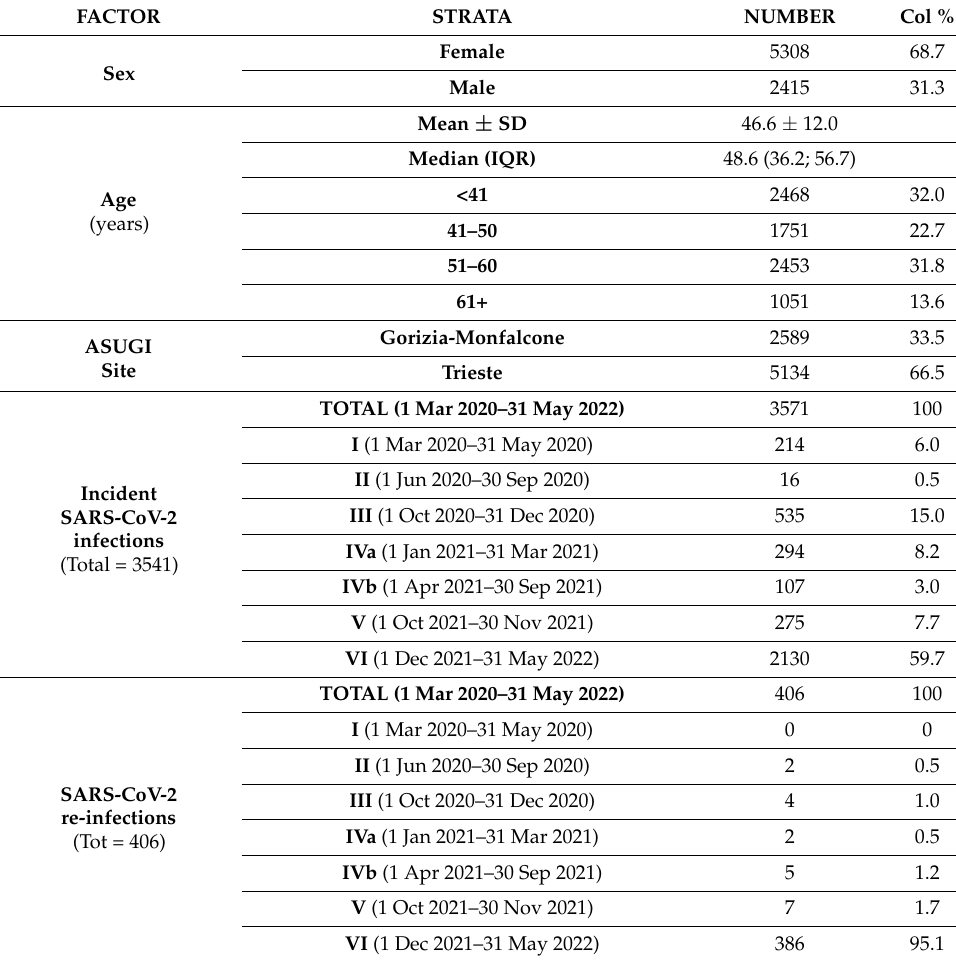
Table 1. Distribution of variables. Number ( N ), percentage (%), mean ± standard deviation (SD), median and interquartile range